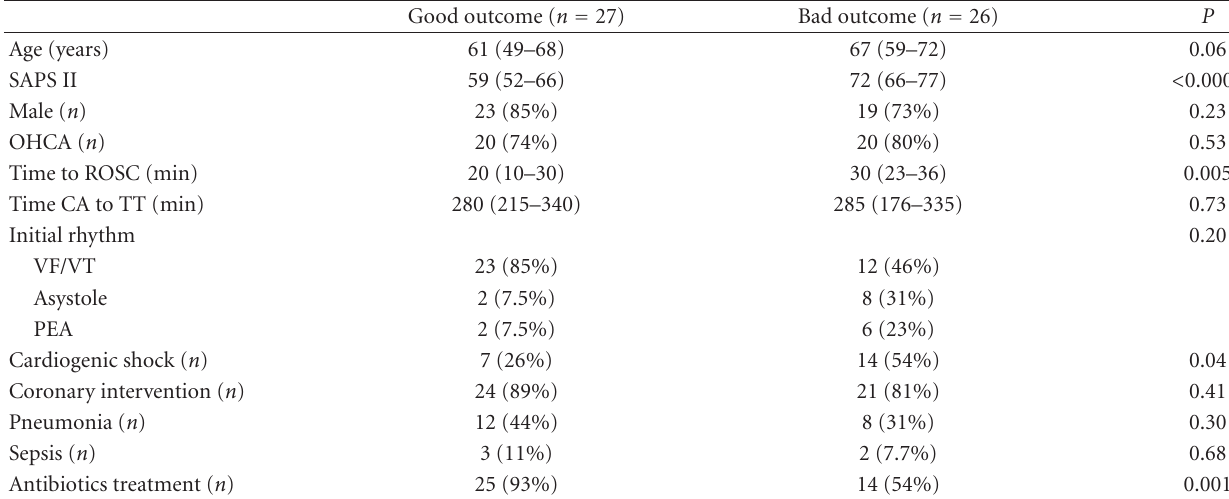
Table 1: Main demographic and Utstein data.